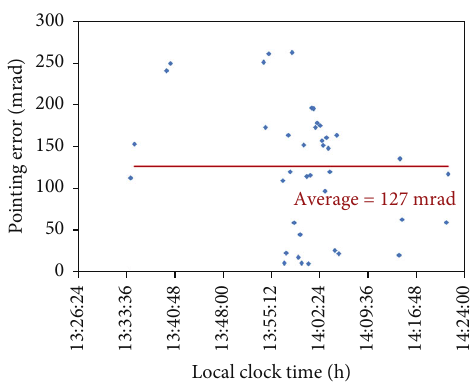
Figure 19: Measurement result of pointing error for prototype mobile sun-tracking system under moving condition using TL mode with t L = 2minutes .